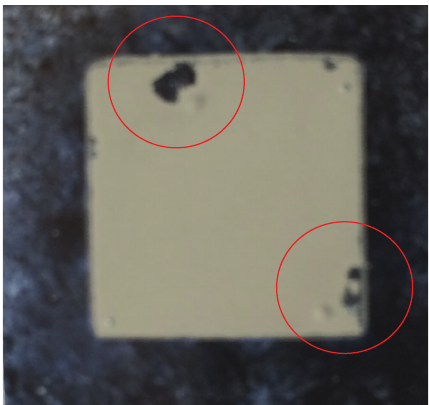
Figure 2: Postannealing condition of Paste 1 where detaching of the paste was observed as circled in red.